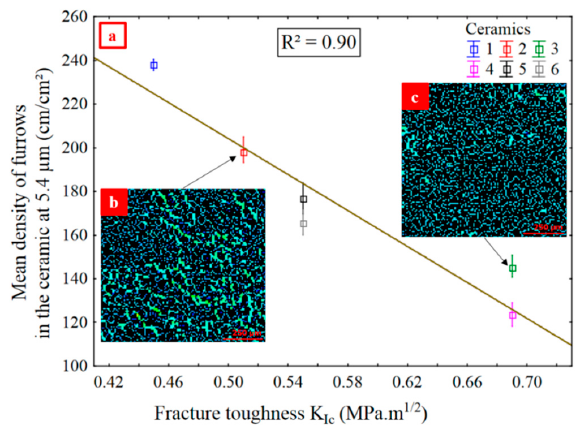
Figure 14. Mean density of furrows versus K Ic , for ceramics, Mehlum curvatures and a band pass filtering at 5.4 µ m ( a ). Density of furrows in grains of ceramic 2 ( b ) and ceramic 3 ( c ), calculated from acquisition images at the same light angular position. MountainsMap ® module.